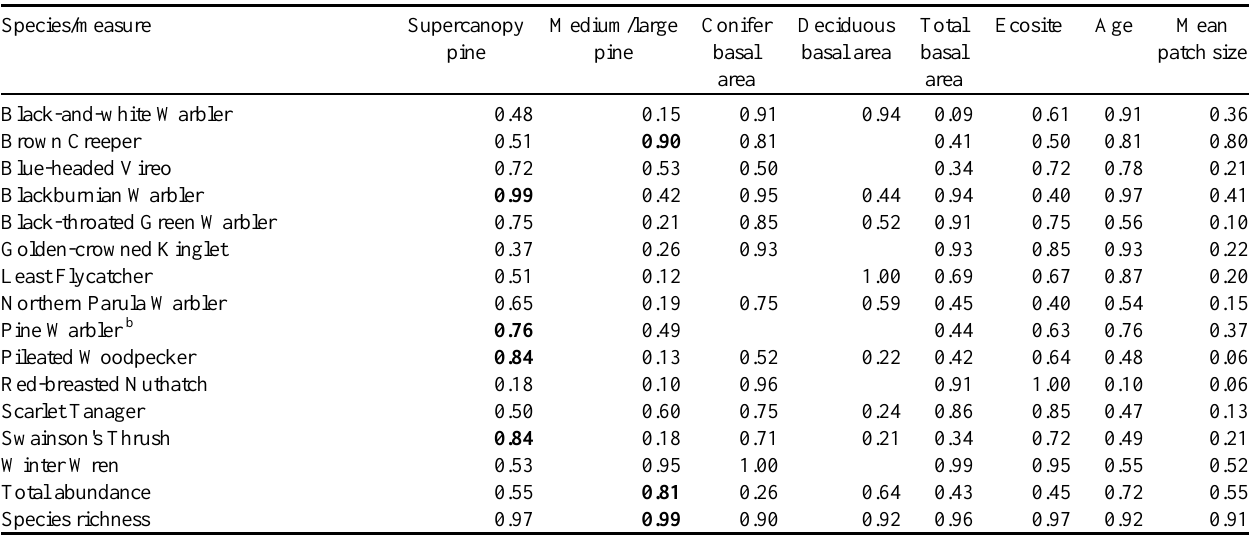
Table 3 . Importance of different variables derived from AIC models for individual species, species richness, and overall abundance. Bolded values indicate species for which pine variables were most important. a Species/measure Supercanopy